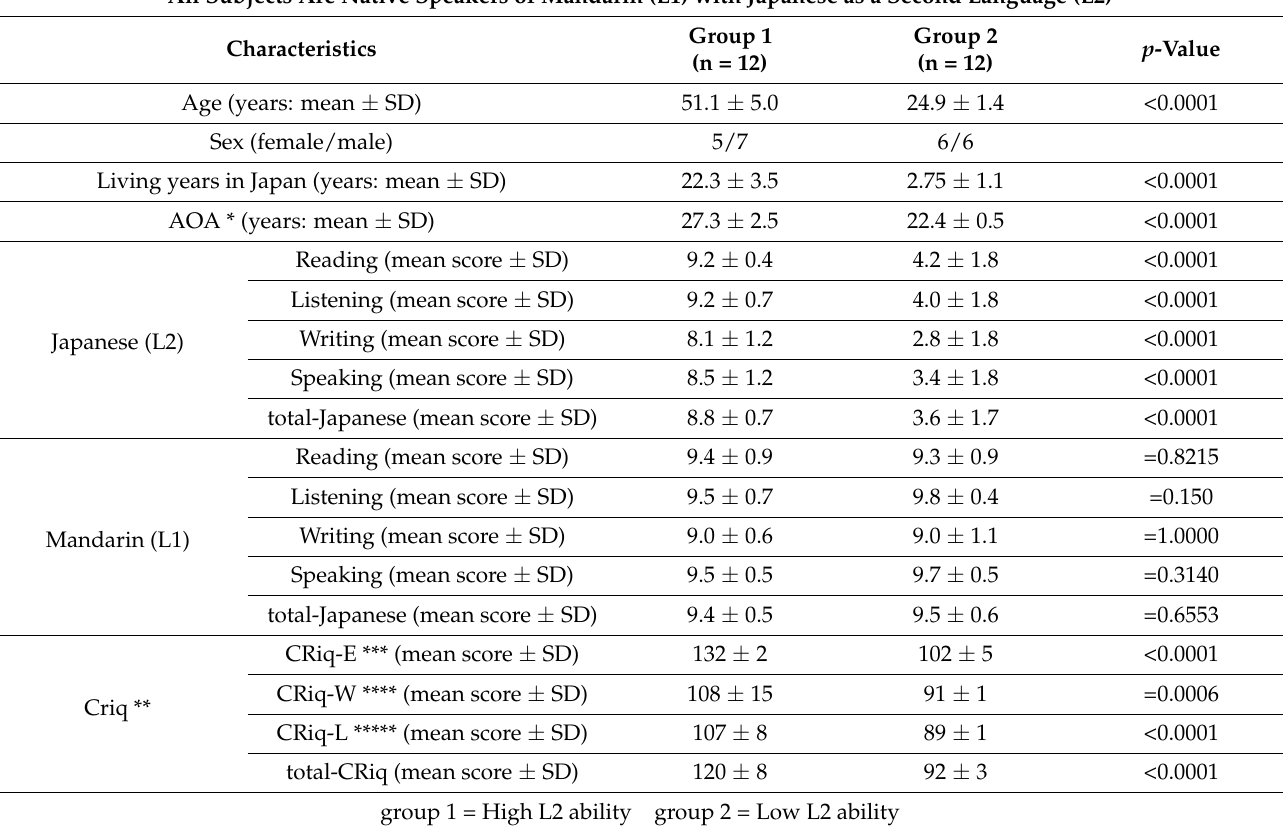
Table 1. Characteristics of study